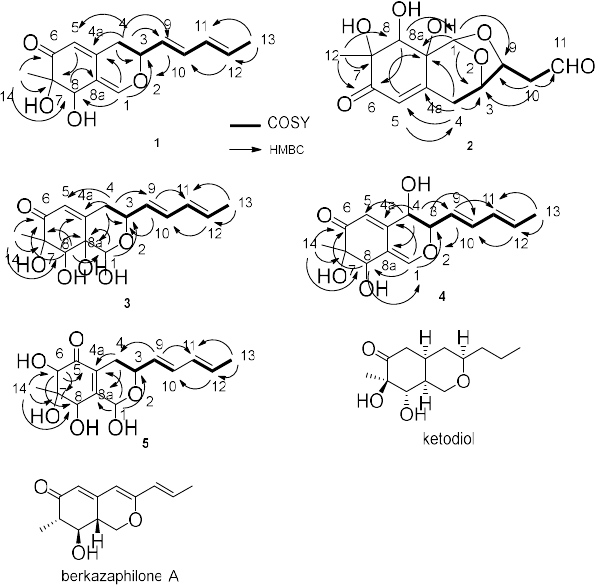
Figure 2. Correlation spectroscopy (COSY) and heteronuclear multiple bond correlation (HMBC) correlations of compounds 1 – 5 , and structures of ketodiol and berkazaphilone A.